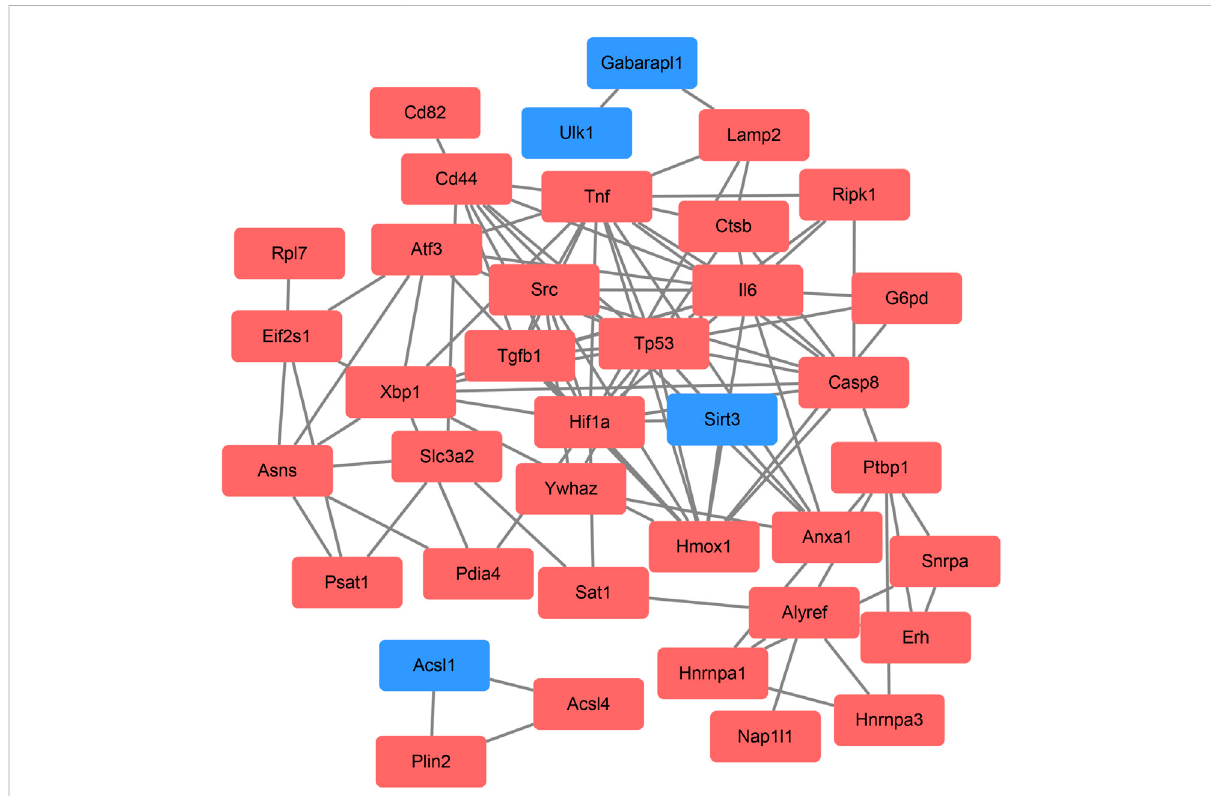
FIGURE 4 Based on the Search Tool for the Retrieval of Interacting Genes database, protein – protein interaction networks of the differentially expressed ferroptosis-related genes were constructed via the Cytoscape software. The red round rectangle indicates upregulated genes, and the blue round rectangle indicates downregulated